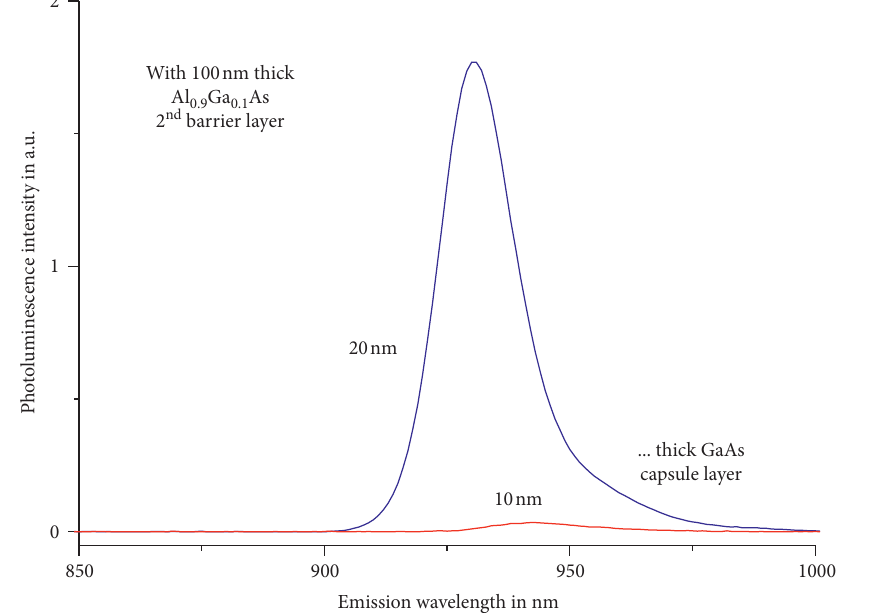
Figure 10: Results of photoluminescence (PL) measurements for two different samples, each with just 1 QD layer, but double-layer barriers. Each barrier is made from a 10 nm or 20 nm thick GaAs capsule layer, respectively, and an Al 0.9 Ga 0.1 As ( x � 0.9!) layer of a thickness of 100nm. The QD layer has been grown as described